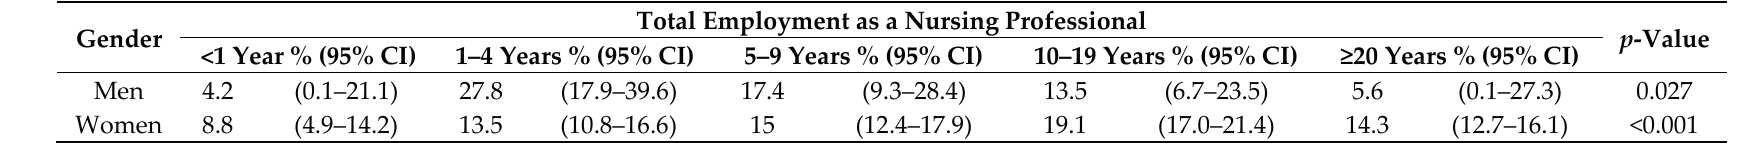
Table 4. Prevalence of wheeze by duration of employment as a nursing professional.